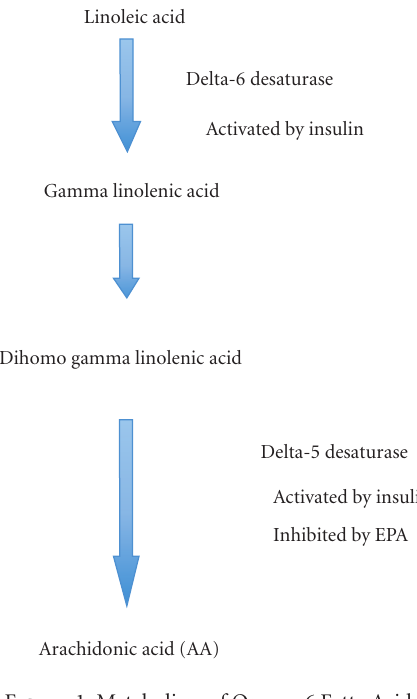
Figure 1: Metabolism of Omega-6 Fatty